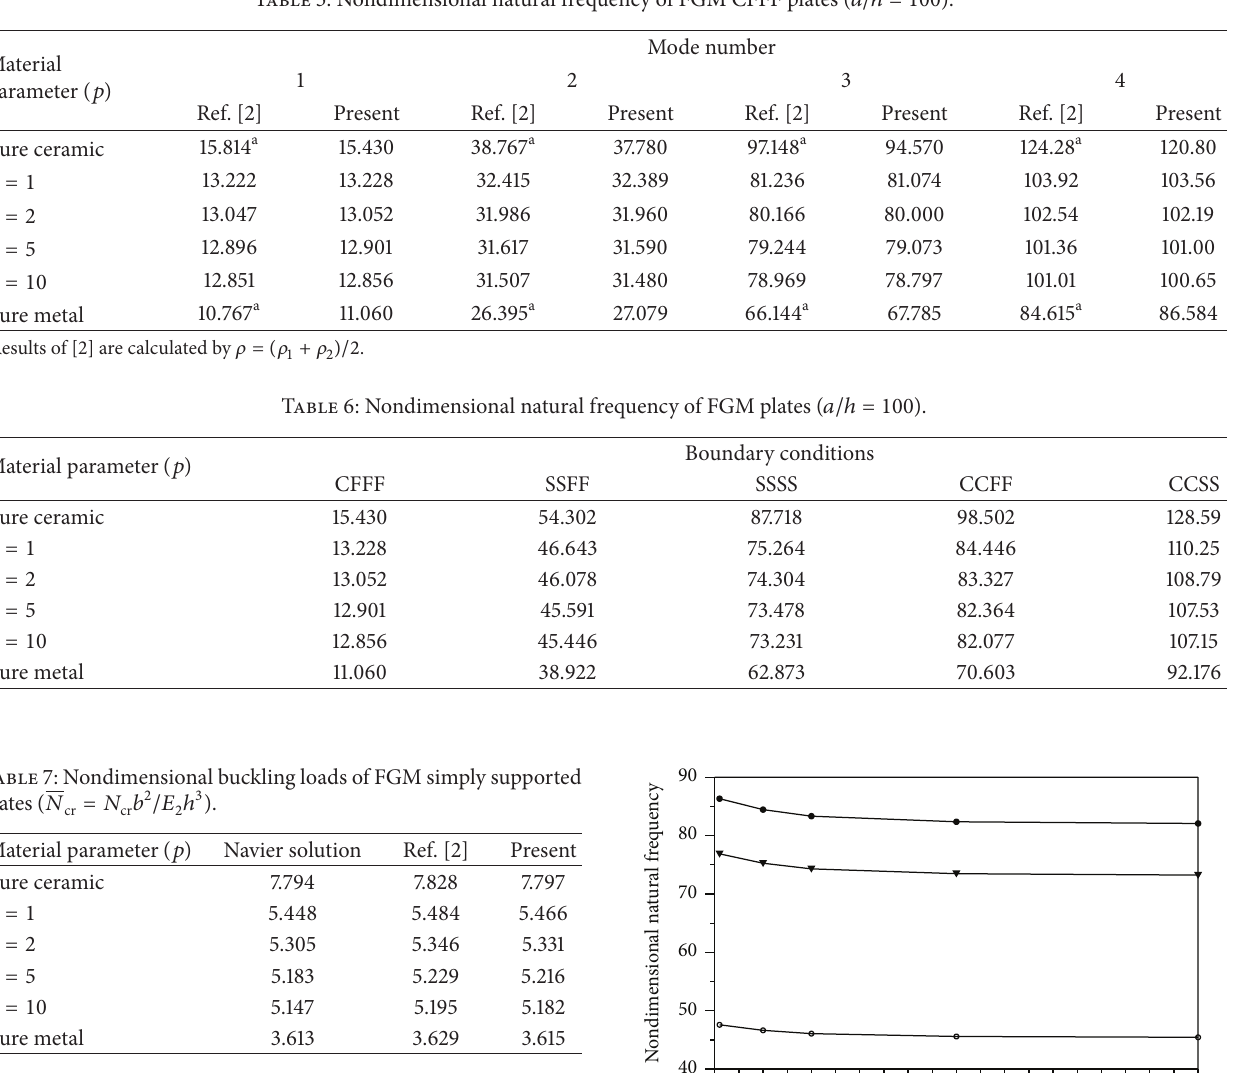
Table 5: Nondimensional natural frequency of FGM CFFF plates ( 𝑎/ℎ = 100 ).